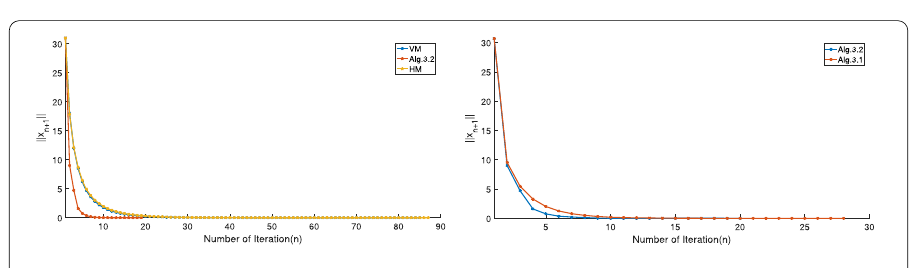
Figure 3 Comparison of Algorithms 3.1 and 3.2 with VM and HM